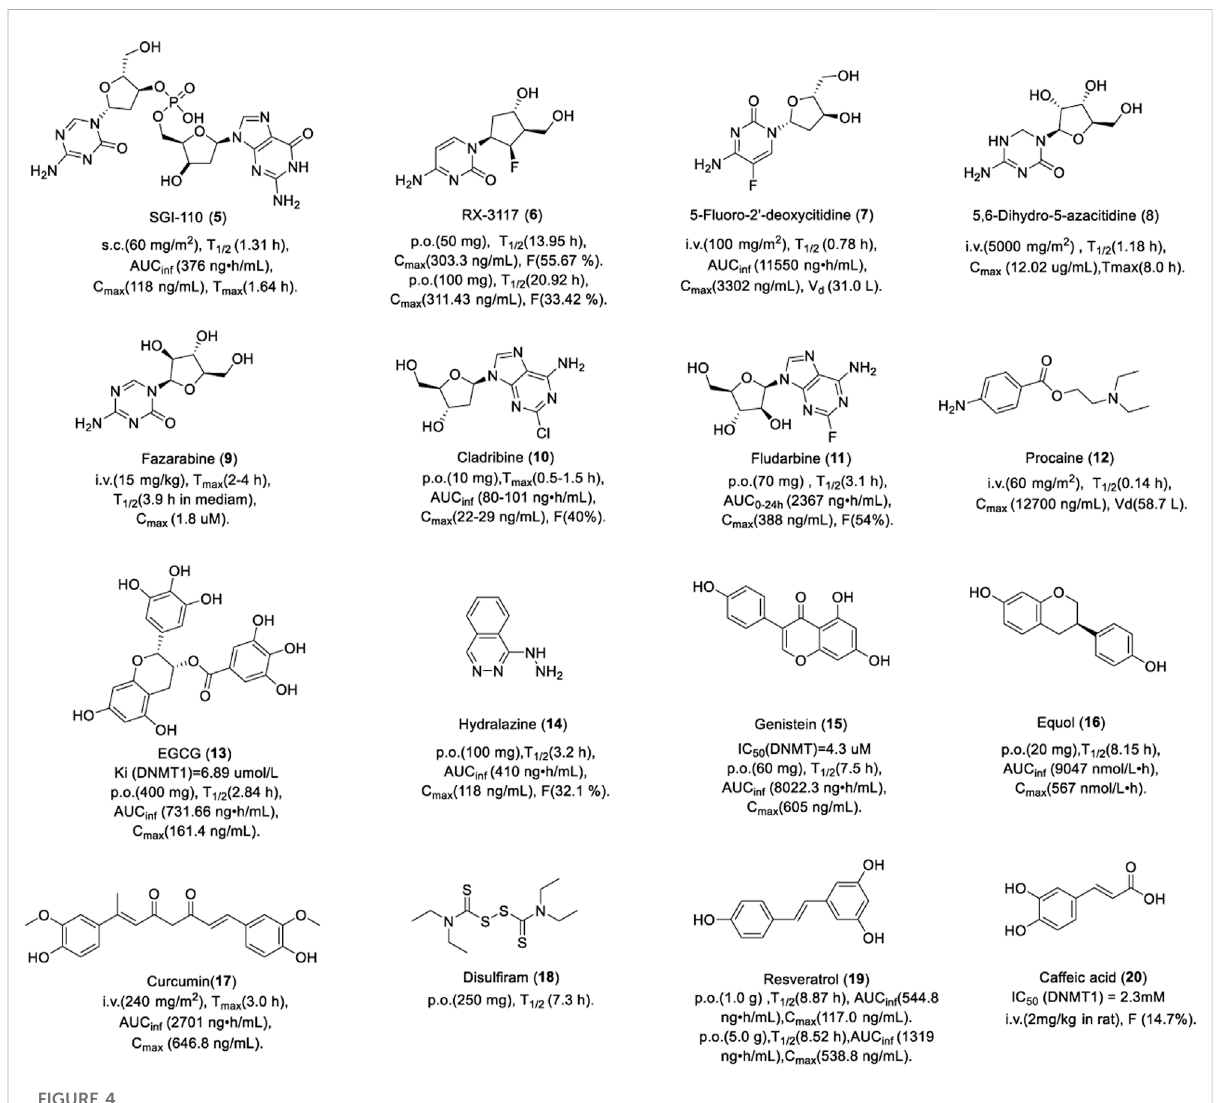
FIGURE 4 Chemical structure of DNMTis in